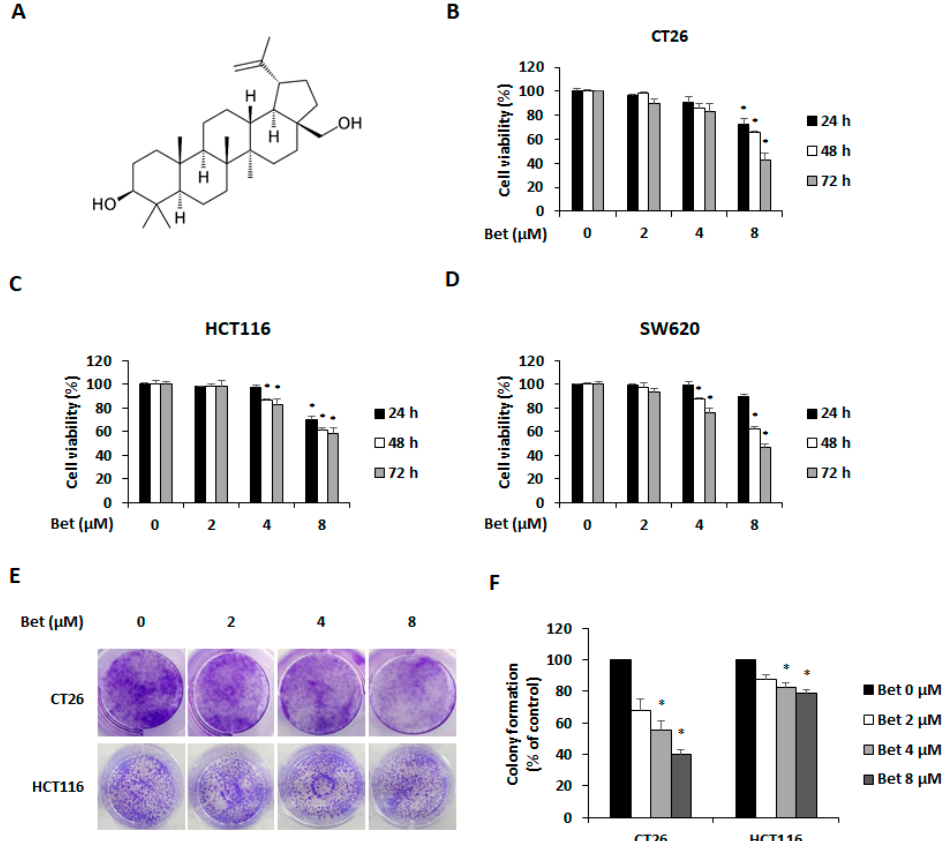
Figure 1. Betulin inhibits viability and colony formation of metastatic colorectal cancer cells. Chemical structure of betulin ( A ). Viability of betulin-treated CT26 ( B ), HCT116 ( C ), and SW620 ( D ) cells. ( E ) Colony formation of CT26 and HCT116 cells with betulin treatment for 7 days. ( F ) Counting of colony formation. Images were captured using phase contrast microscope (magnification, 200 × ). Data are means ± standard deviation of three independent experiments. * p < 0.05.